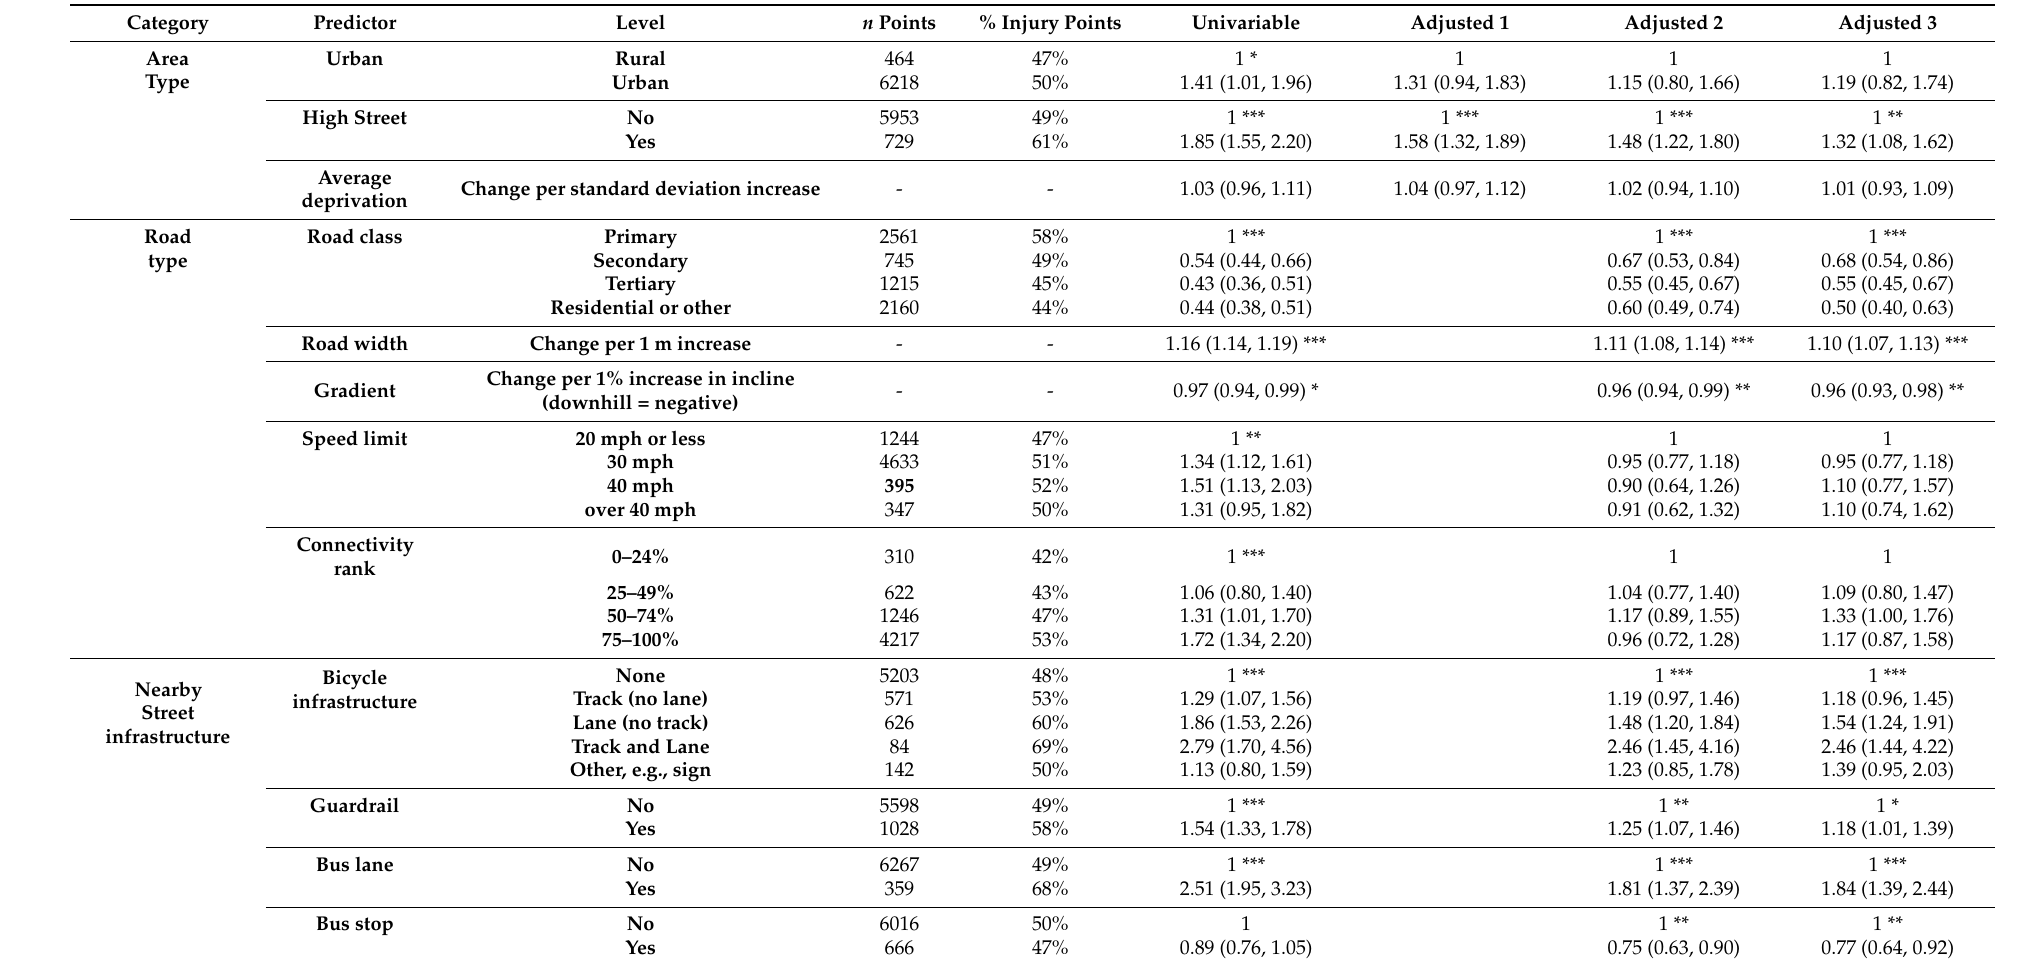
Table 2. Predictors of injury, all